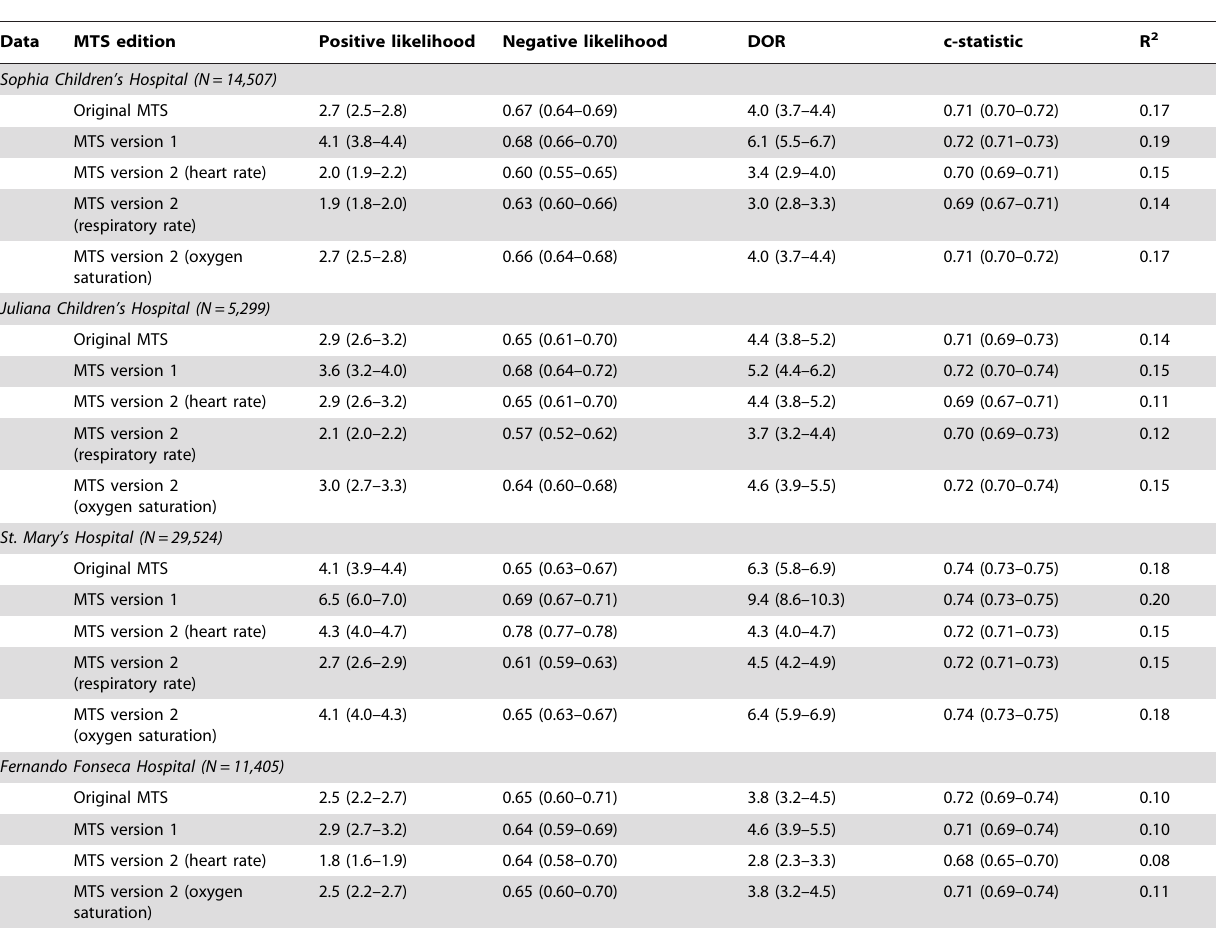
Table 5. Performance of the original MTS, MTS version 1, and MTS version 2 per